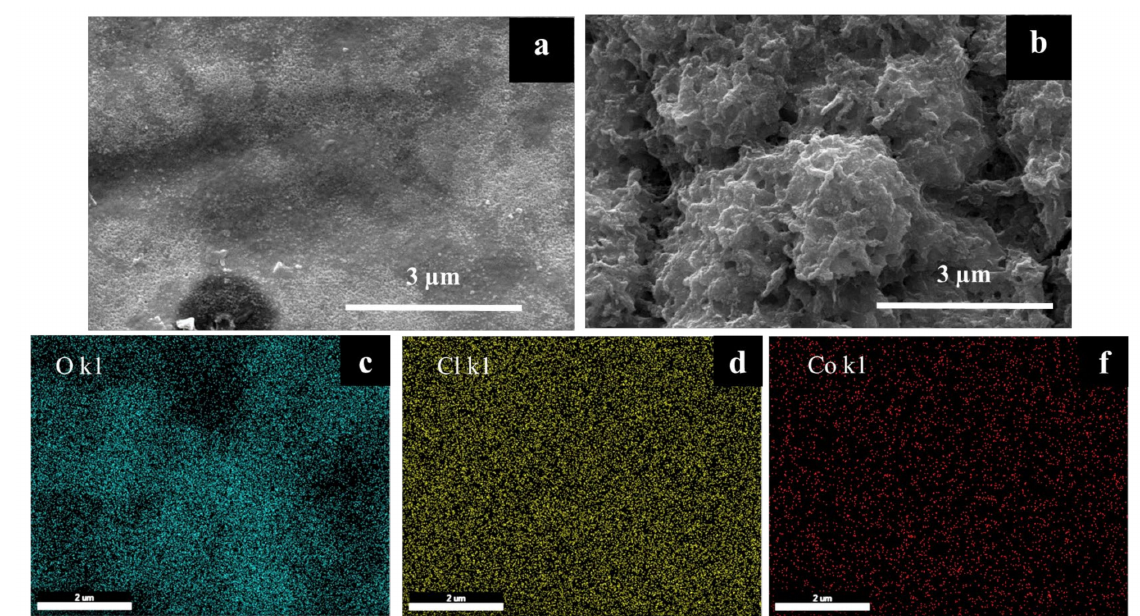
Figure 1. Surface analysis using FE-SEM and elemental mapping images of the electrode modified with GO/Co/chitosan in the developed biosensor: ( a ) bare electrode; ( b ) modified electrode with GO/Co/chitosan. Elemental mapping images of ( c ) O; ( d ) Cl; ( f ) Co; EDS